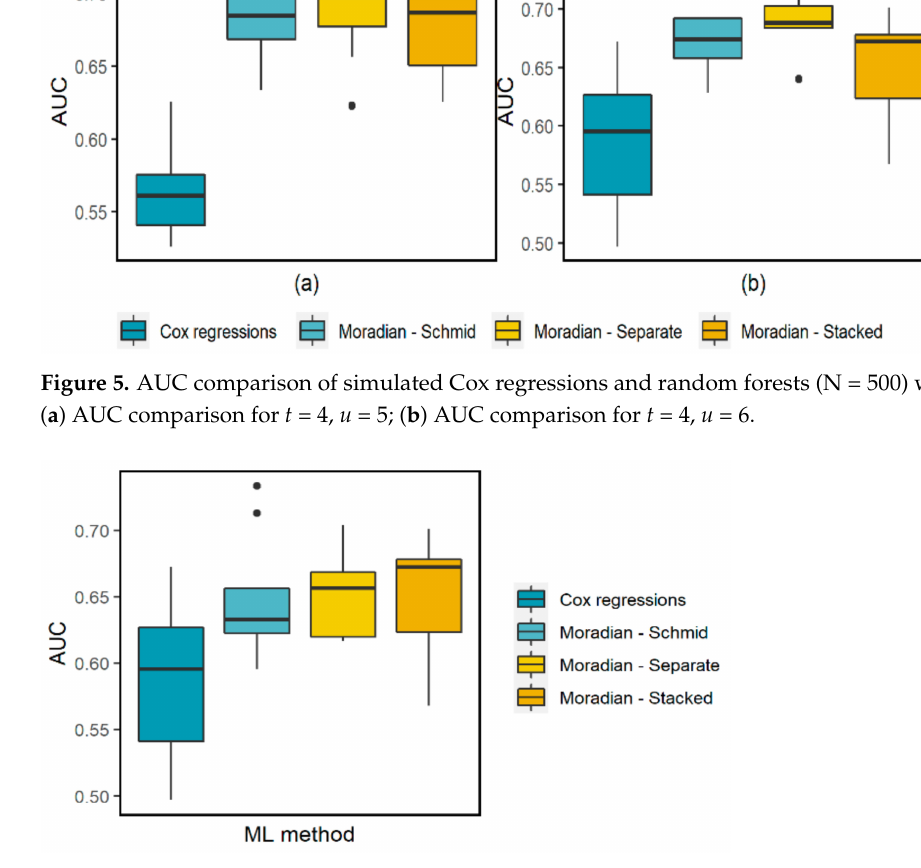
Figure 6. AUC comparison of simulated Cox regressions and random forests (N = 500) when t = 5 and u =